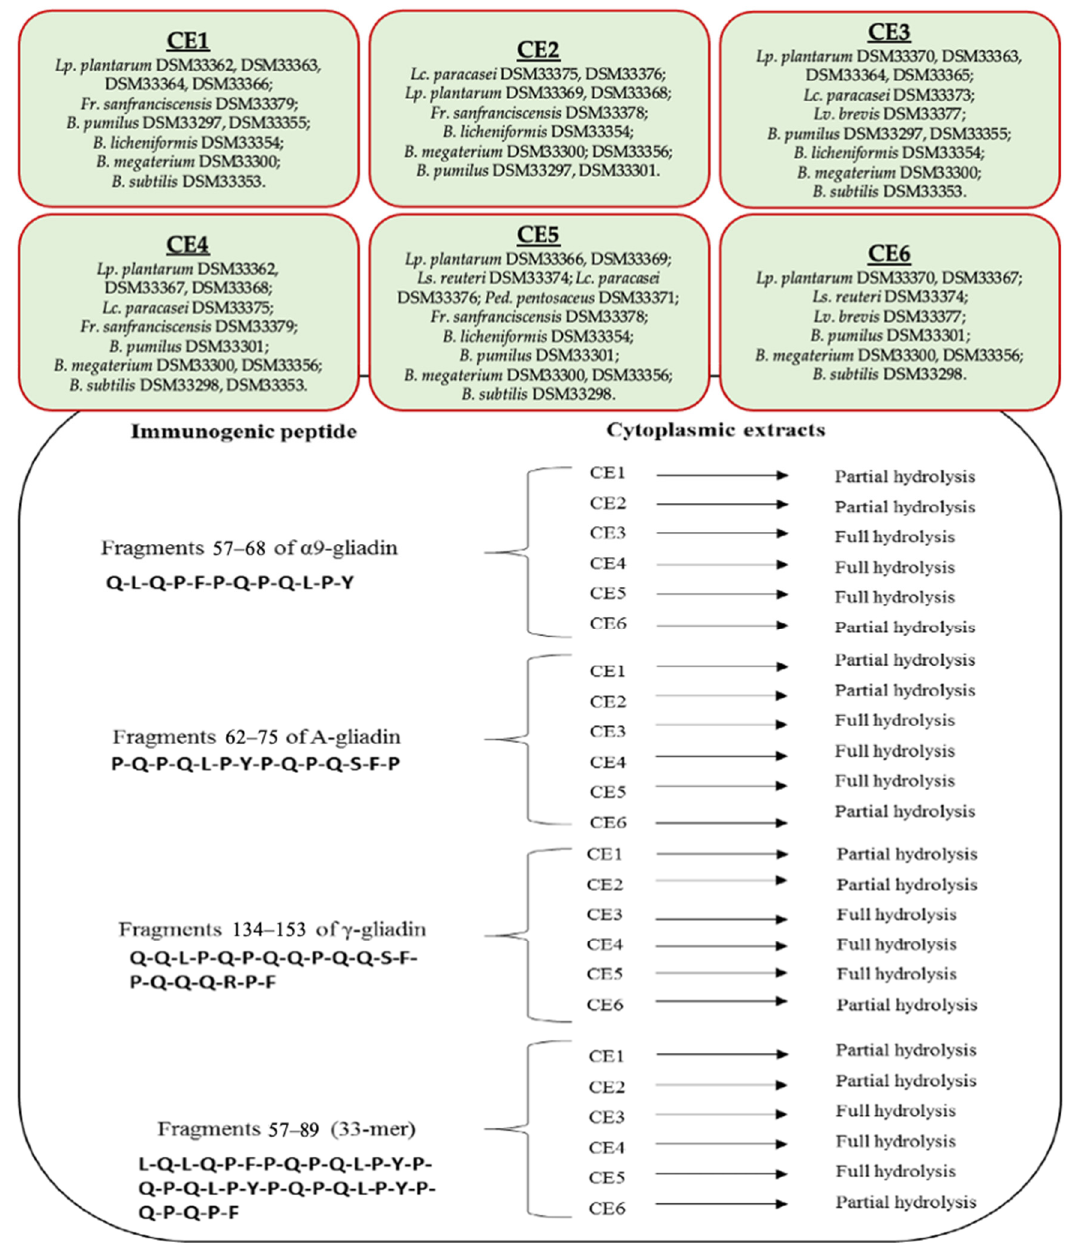
Figure 3. The tested bacterial cytoplasmic extracts (CE1–CE6) and the related peptidase activities against immunogenic epitopes.